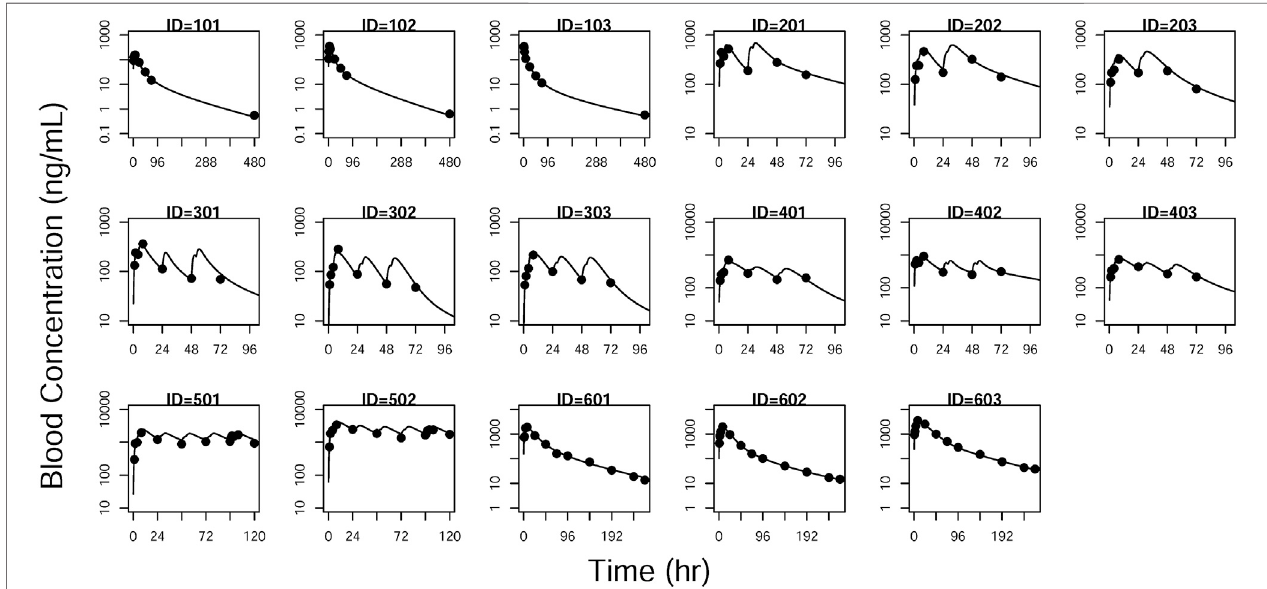
Frontiers in Pharmacology |